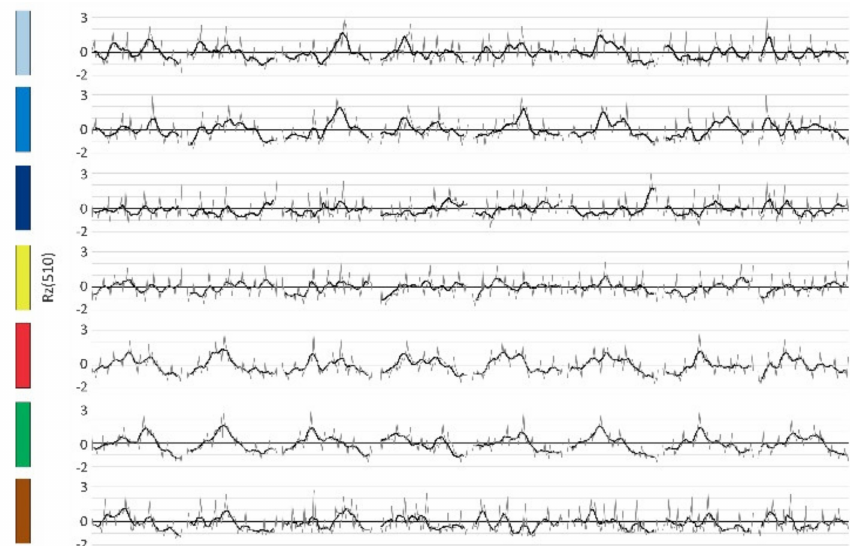
Figure 8. The R z (510) prototypes of the clusters, with the colors from the image “C1–C7” in Figure 7. A moving average of ten days was used for a clearer